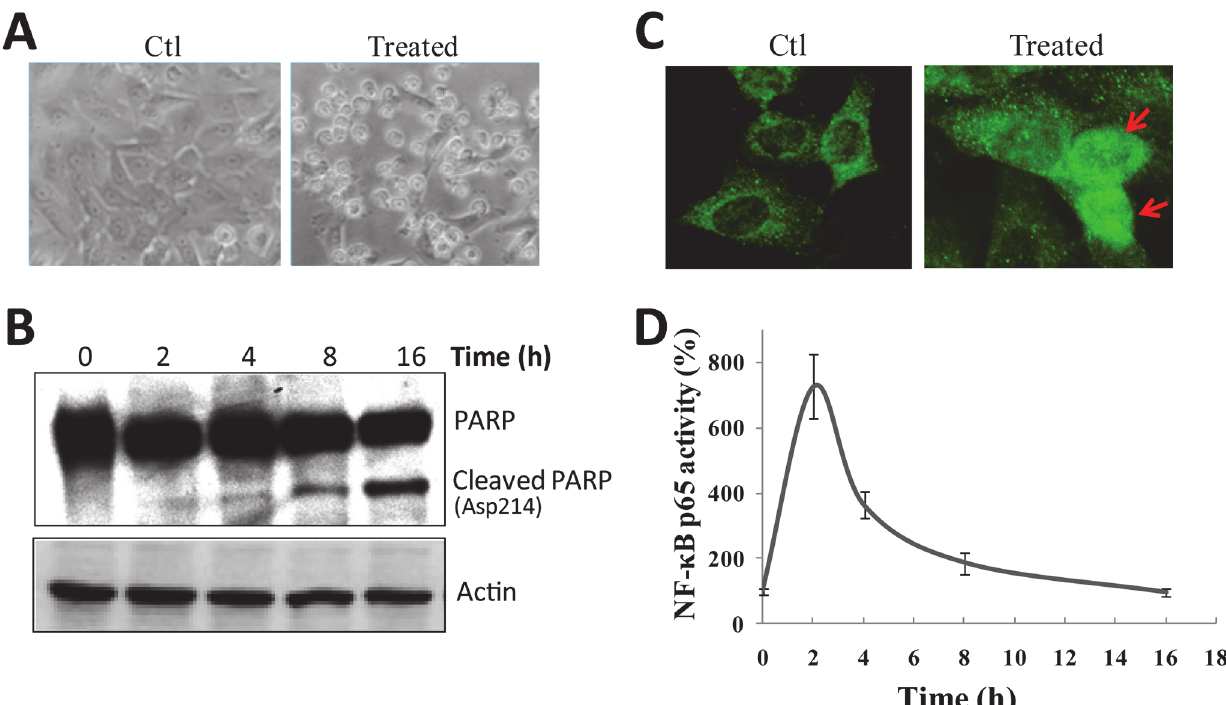
Fig 1. NF- κ B is involved in Fas-induced cell apoptosis in neuroblastoma cells. ( A ) SH-EP1 cells were treated with agonistic anti-Fas antibody (100 ng/ml) for 1 d, and photographed live. Pictures are shown at ×100 magnification. ( B ) Immunocytochemistry targeting NF- κ B p65 (green) was performed at 1 h after Fas treatment. Arrows indicate cells with p65 nuclear translocation. ( C ) Treated cells were lysed and Western blotting was performed with antibody against the cleaved PARP. Membranes were re-probed with β -actin as a loading control. Results are representative of at least three experiments. ( D ) After Fas treatment, NF- κ B activation was analyzed using NF- κ B p65 reporter assay. Data are from three repeated experiments and shown as average ± s.e.m. (bars) values. ** P < 0.01 and *** P < 0.001, compared with untreated SH-EP1